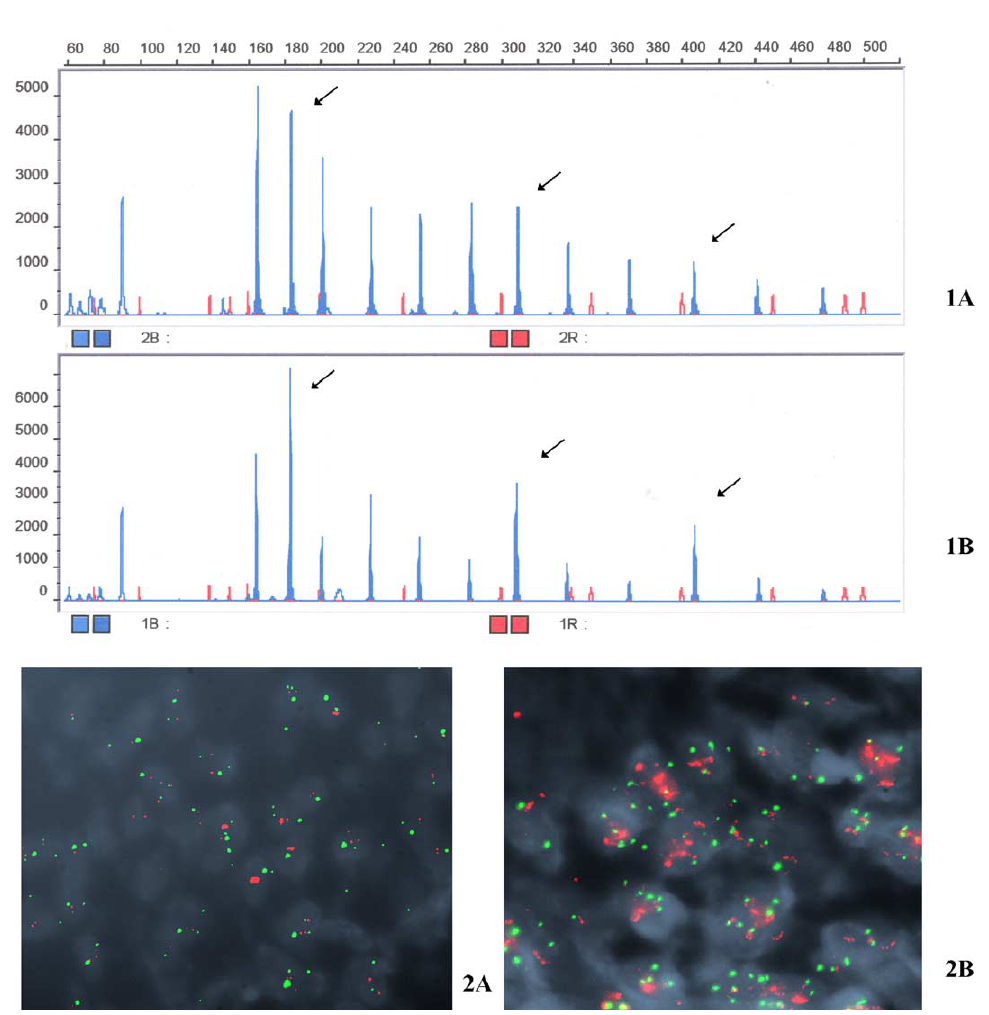
Fig. 1. Representative results of HER2 MLPA and FISH. 1: MLPA peak profile showing three HER2 probes (indicated by arrows), other peaks correspond to control probes. 2: Images of FISH results with HER2 signals in red and centromere 17 control signals in green, counterstained DAPI (magnification × 1000). 1A and 2A are showing a non-amplified sample (#20 IHC 2 + ) both in MLPA (ratio 1.2) and in ISH (ratio 1.0). In 1B and 2B a sample with a HER2 amplification is shown (sample #2 IHC 2 + ) in MLPA (amplification ratio 2.9) and in FISH ratio